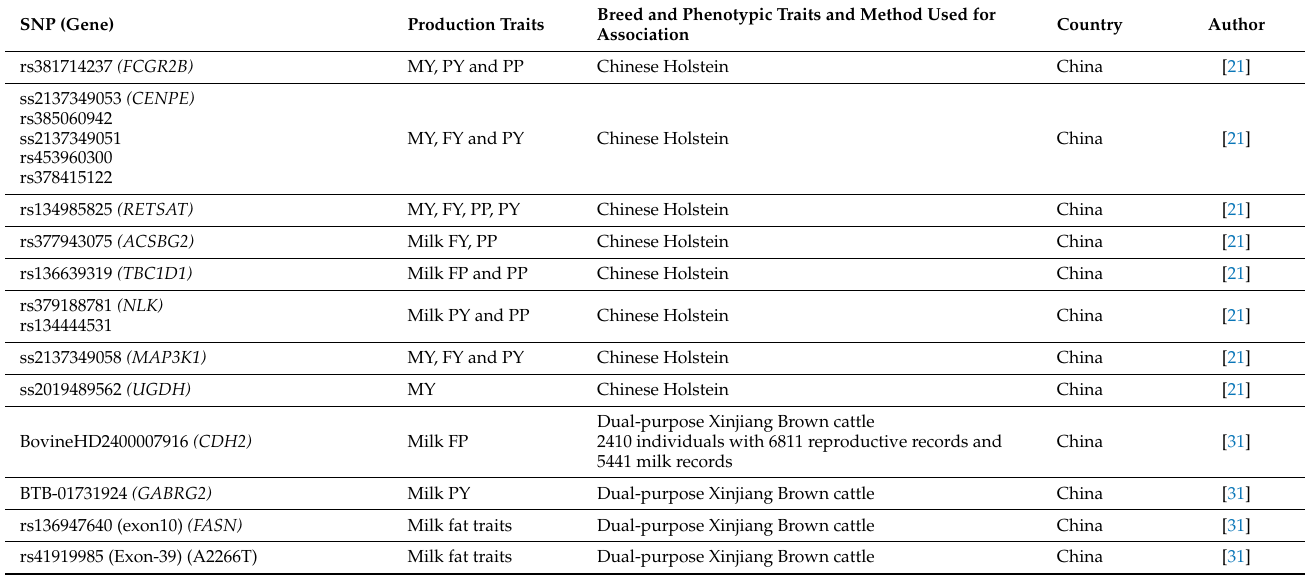
Table 1. GWAS study for screening genetic markers associated with milk production trait. Production Traits Breed and Phenotypic Traits and Method Used for